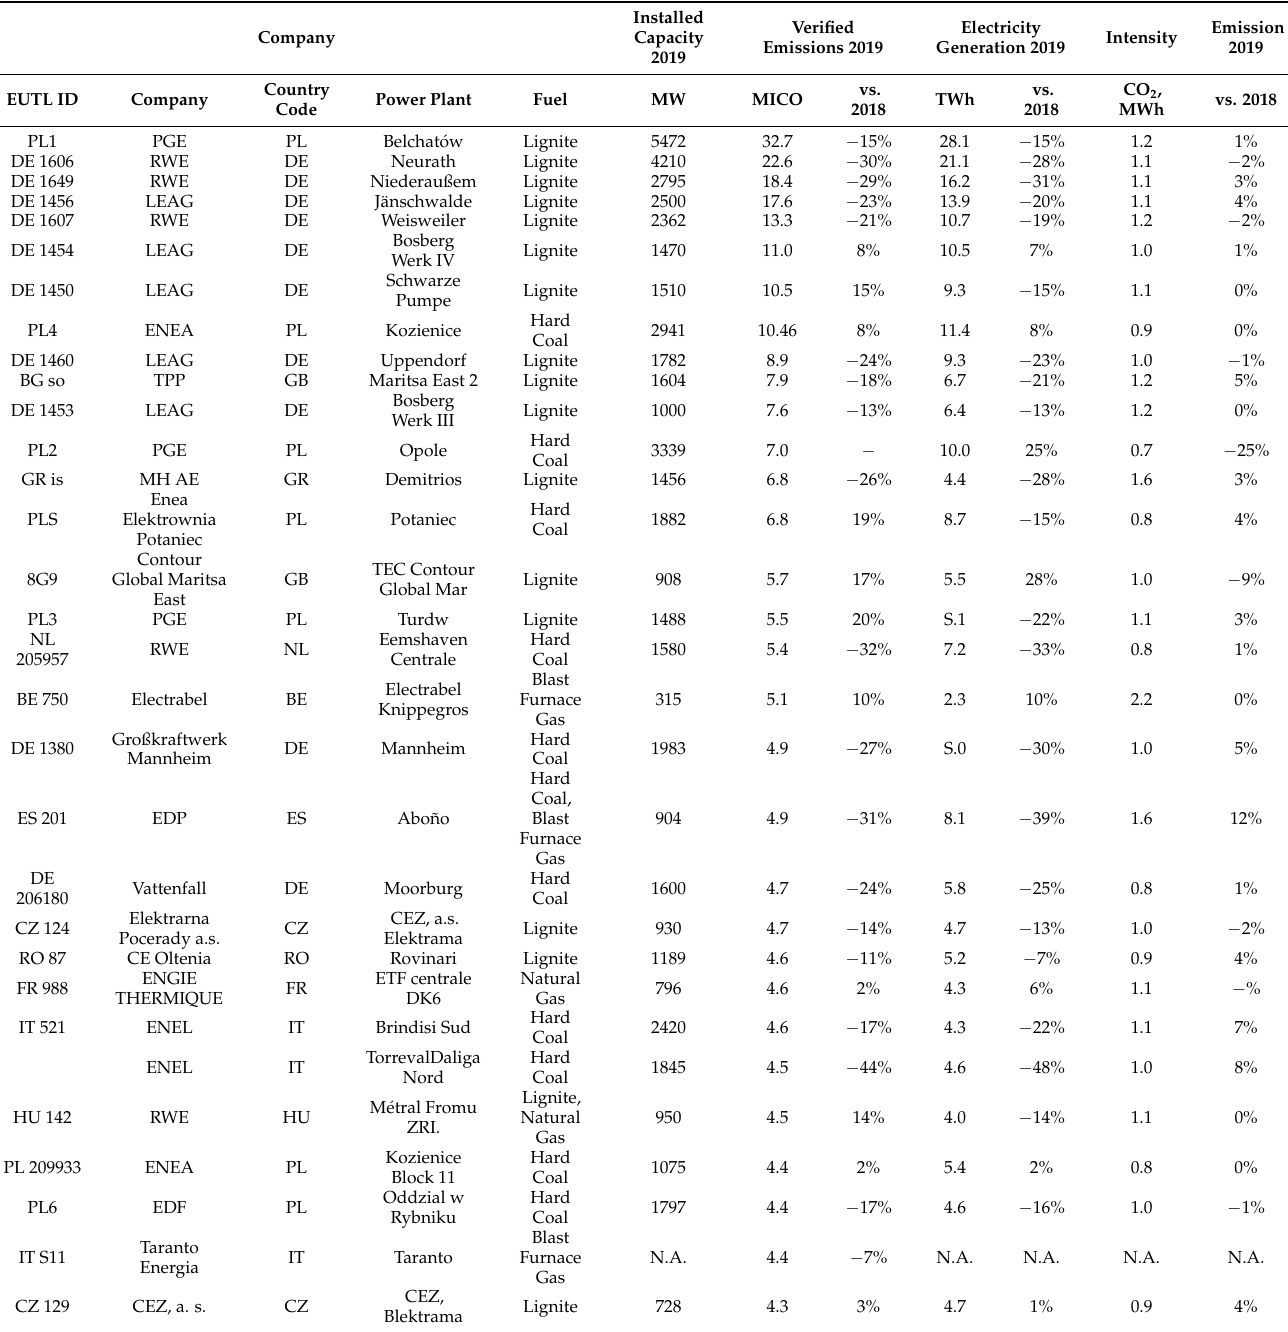
Table 5. Top 30 emitters in 2019 (power plants) in the European